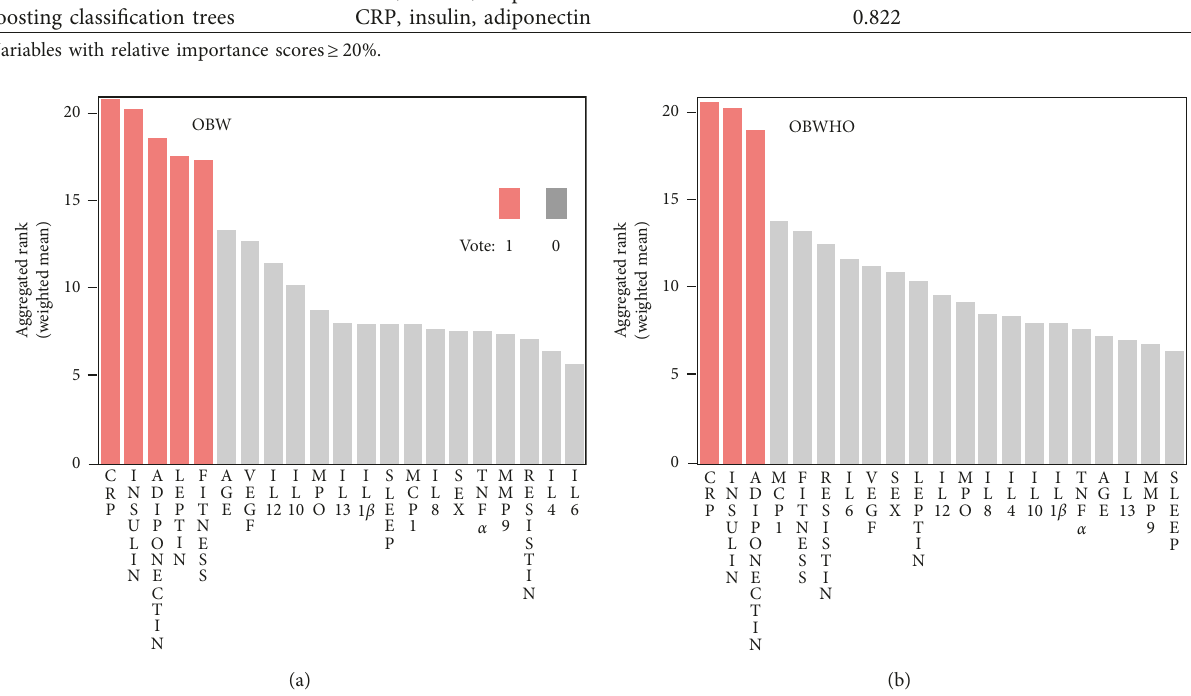
Figure 1: Aggregated ranking of all variables derived from variable importance rank lists generated from Lasso, MARS, RF, and BT. The variables in red indicate they were identified by at least three of the above algorithms (Vote as 1). For obesity as defined by (a) waist circumference (OBW) and (b) BMI